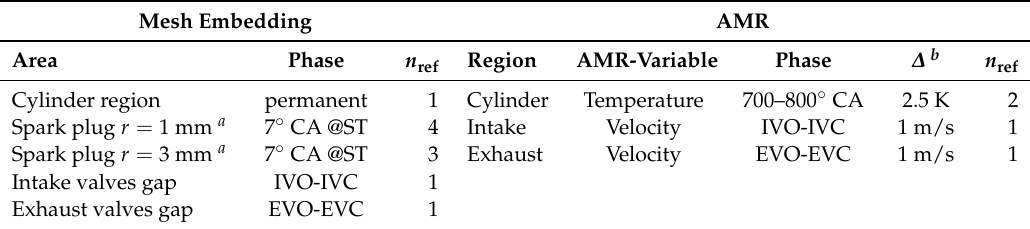
Table A2. Geometry meshing parameters. Base mesh size δ = 2 mm. AMR, automatic mesh refinement; EVO, exhaust valve opening; EVC, exhaust valve